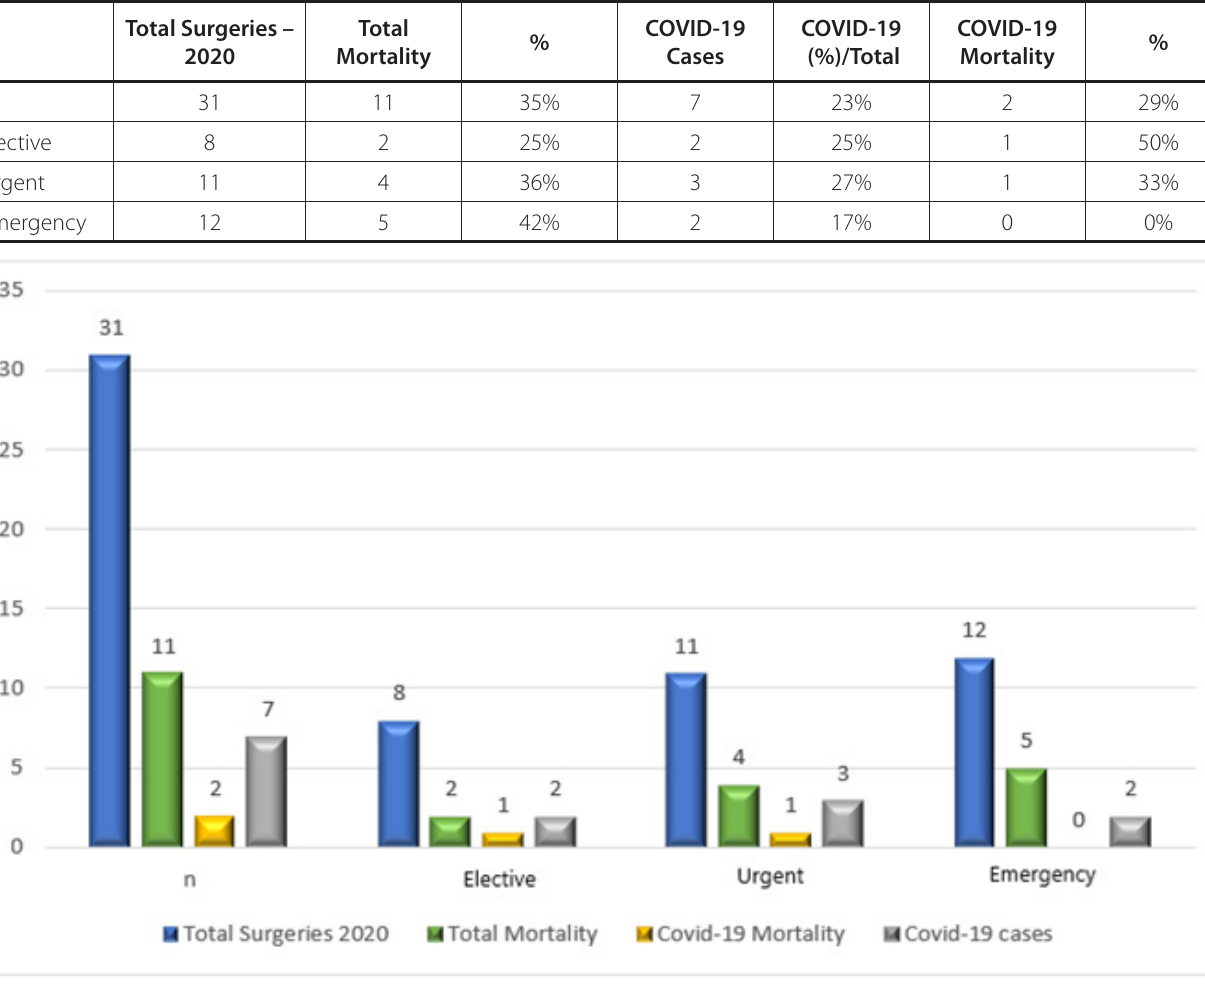
Table 2 . 2020 total surgeries and hospital mortality, total coronavirus disease 2019 (COVID-19) cases, and mortality, in the three different clinical presentations for